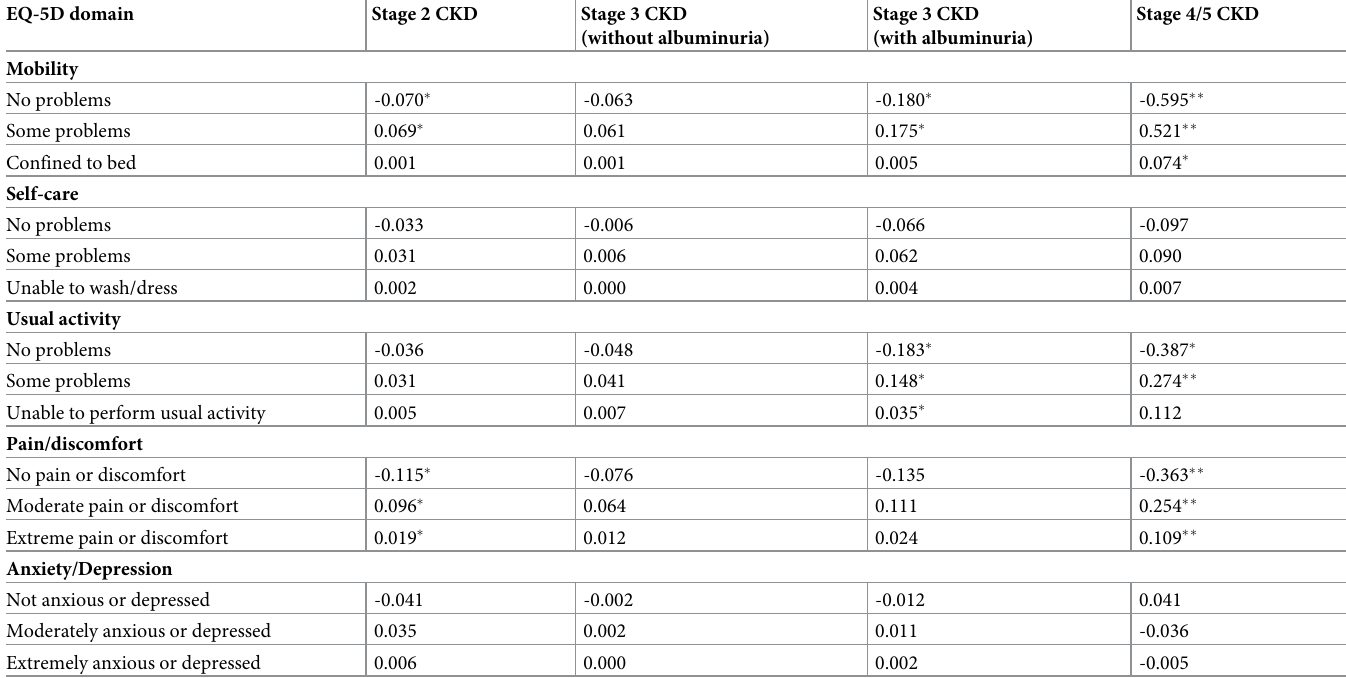
Table 2. Estimated marginal